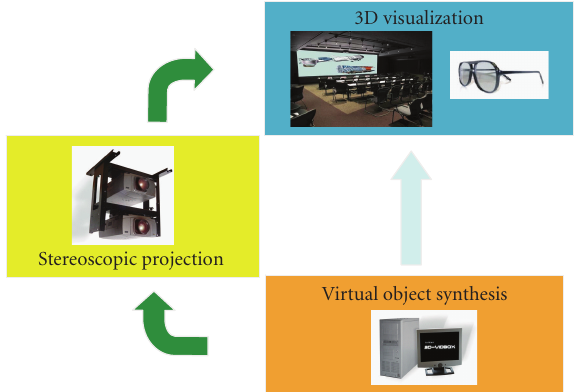
Figure 1: Video rendering system for the students’ class.